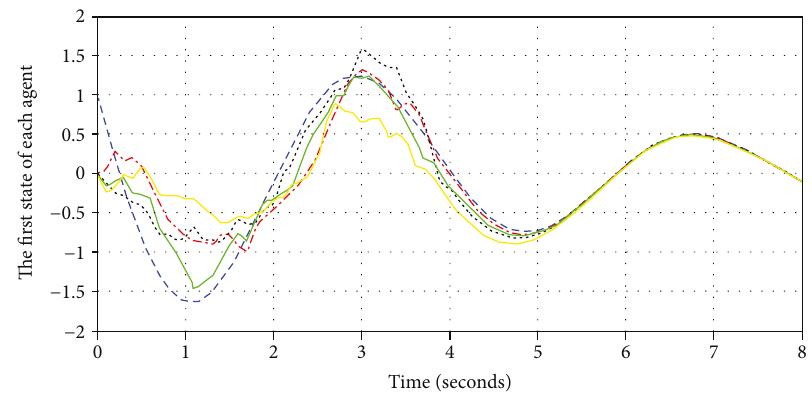
Figure 2: The fi rst state component of each agent.